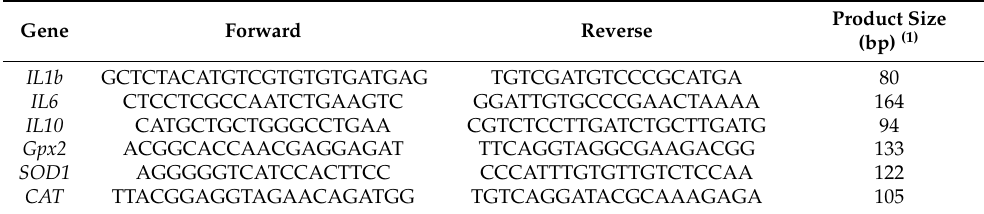
Table 2. List of chicken primers used for this